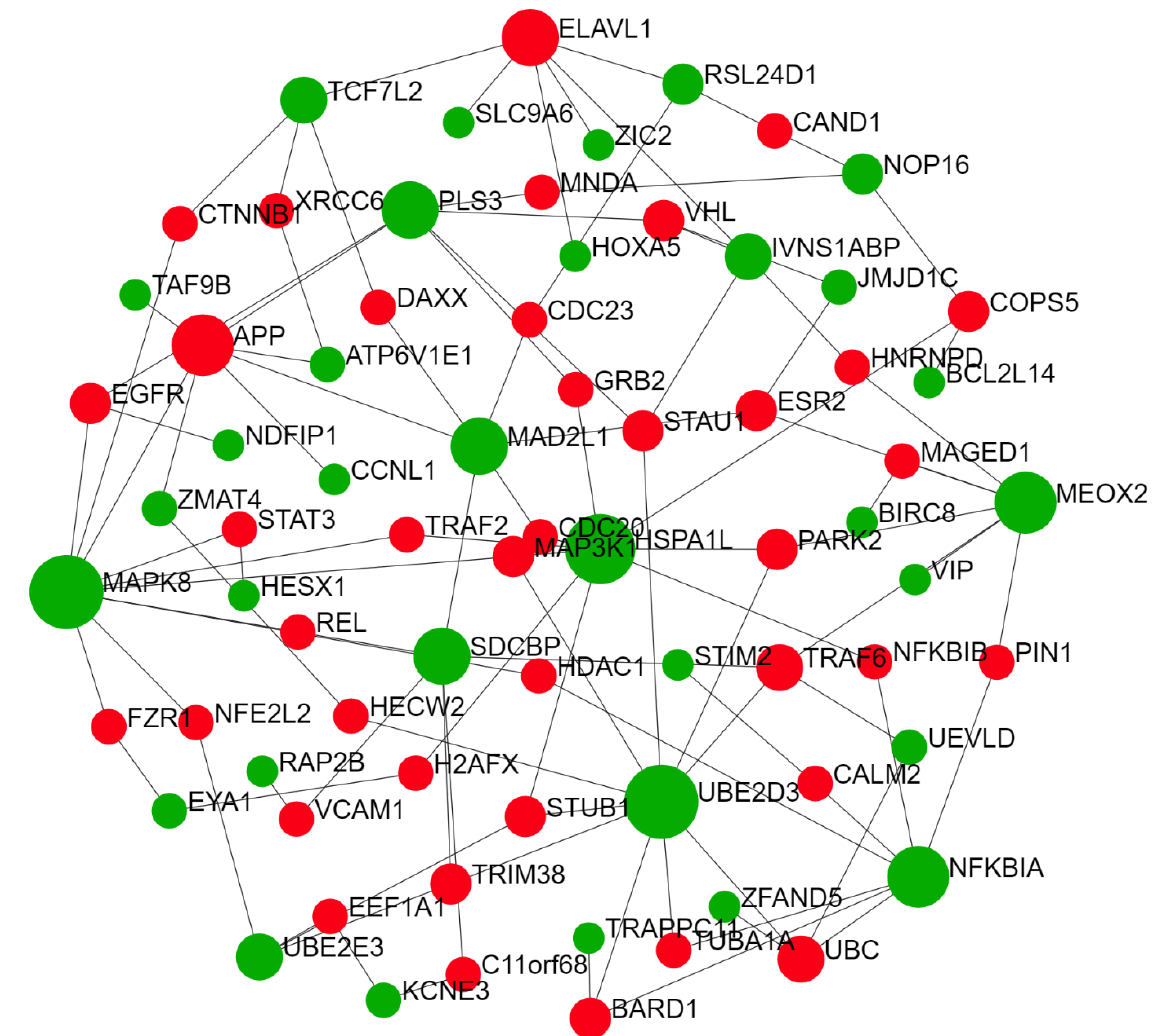
Figure 1. Tissue-specific protein–protein interaction network related to miR-499 functional modules. This network revealed MEOX2 , SDCBP , UBE2D3 , MAPK8 , and NFKBIA as main hub-driver nodes (green nodes) in thyroid tissue (for statistical network details, see Supplementary File S1). These genes are mainly implicated in adaptive and innate immune system antigen processing and pattern recognition, mainly throughout toll-like receptors (TLRs) signaling. miR, microRNA; MEOX2, mesenchyme homeobox 2; SDCBP, syndecan binding protein; UBE2D3, ubiquitin-conjugating enzyme E2 D3; MAPK8, mitogen-activated protein kinase 8; NFKBIA, nuclear factor-kappa B inhibitor alpha.